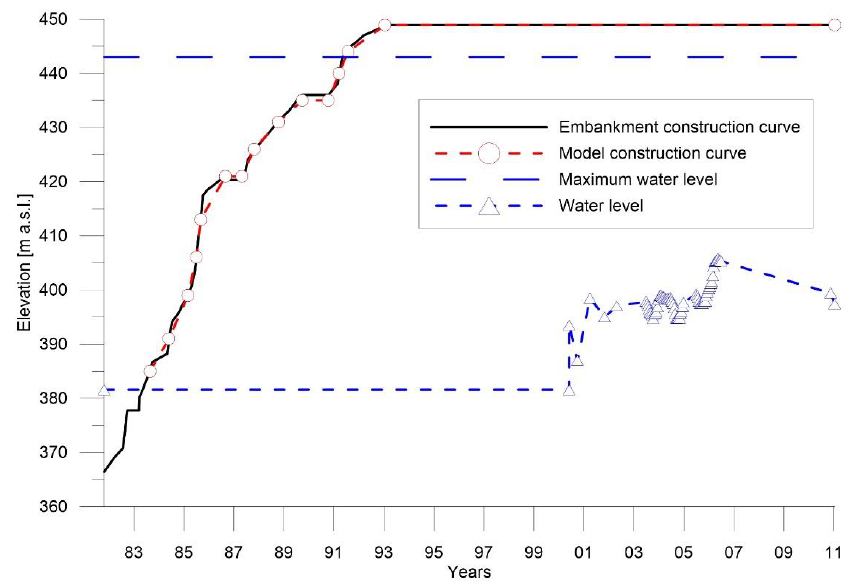
Figure 19. Curve construction of the dam.